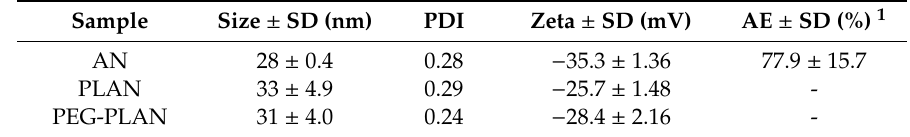
Table 1. The size (mean diameter ± SD) and distribution (PDI), zeta potential (mean ζ ± SD)) and association e ffi ciency (AE) for OVA of the ANs, PLANs, and PEG-PLANs ( n =